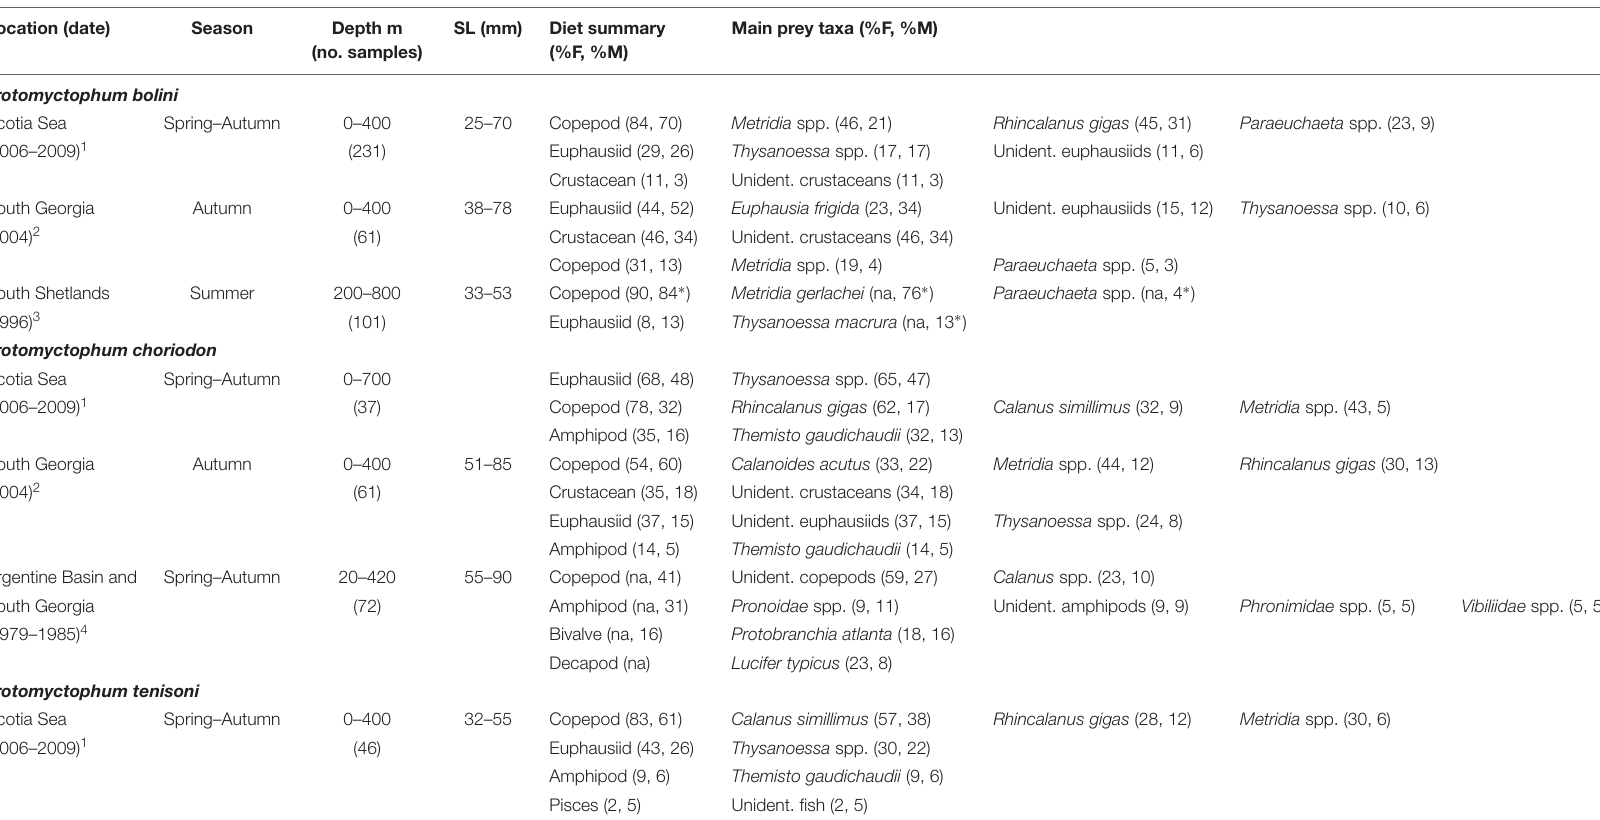
TABLE 4 | Diet of Protomyctophum bolini , Protomyctophum choriodon , and Protomyctophum tenisoni in the Scotia Sea expressed by percentage frequency of occurrence (%F) and percentage mass